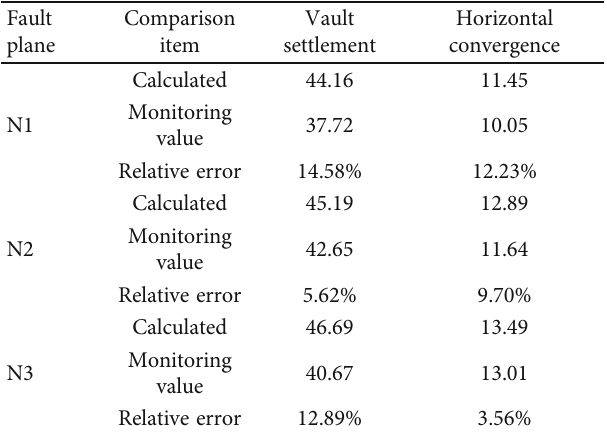
Table 5: Comparison of calculated and measured values (unit: mm). Fault Comparison Vault plane item settlement